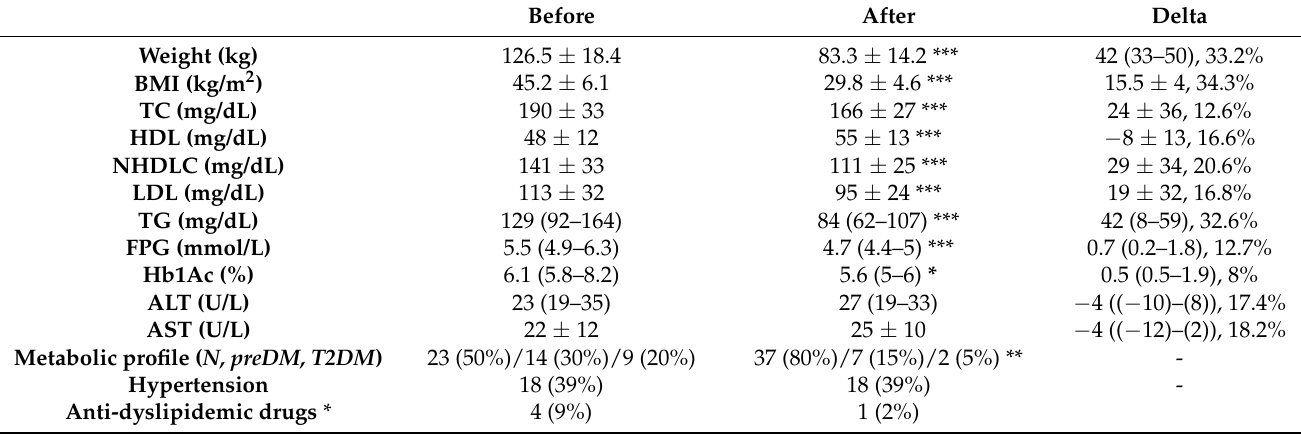
Figure 1 represented the difference in the prevalence of dyslipidemia after LSG (before surgery 52%, after surgery 49%, p = 0.763) and OAGB, showing a statistically significant slowing only after OAGB (before surgery 61%, after surgery 22%, p < 0.001). Table 4 highlighted the differences between the changes before and after (delta, ∆ ) the two surgery procedures. The difference in weight loss was greater after OAGB than LSG ( ∆ weight: 42.0 kg versus 37.6 kg, p = 0.024) with a corresponding statistically significant decrease of ∆ BMI (15.5 kg/m 2 versus 13.7 kg/m 2 , p = 0.032). The difference in each plasma lipid levels was expressed both without and after adjustment for delta BMI, age and sex. We demonstrated a statistically significant decrease of ∆ TC values ( p < 0.001, Table 4 and Figure 2A), ∆ NHDLC values ( p < 0.001, Table 4), ∆ LDL values ( p < 0.001, Table 4 and Figure 2B) and ∆ TG values ( p = 0.007, Table 4 and Figure 2C), after adjustment for